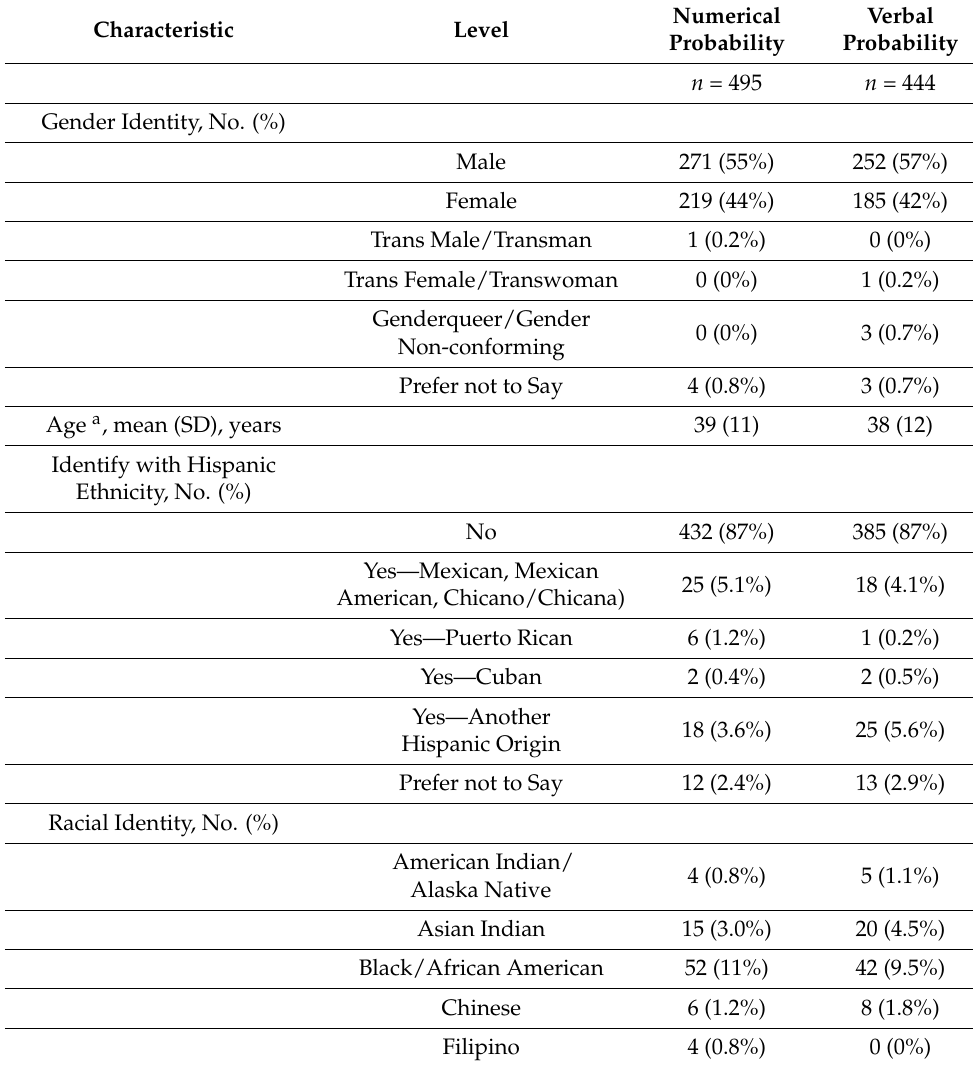
Table 1. Participant